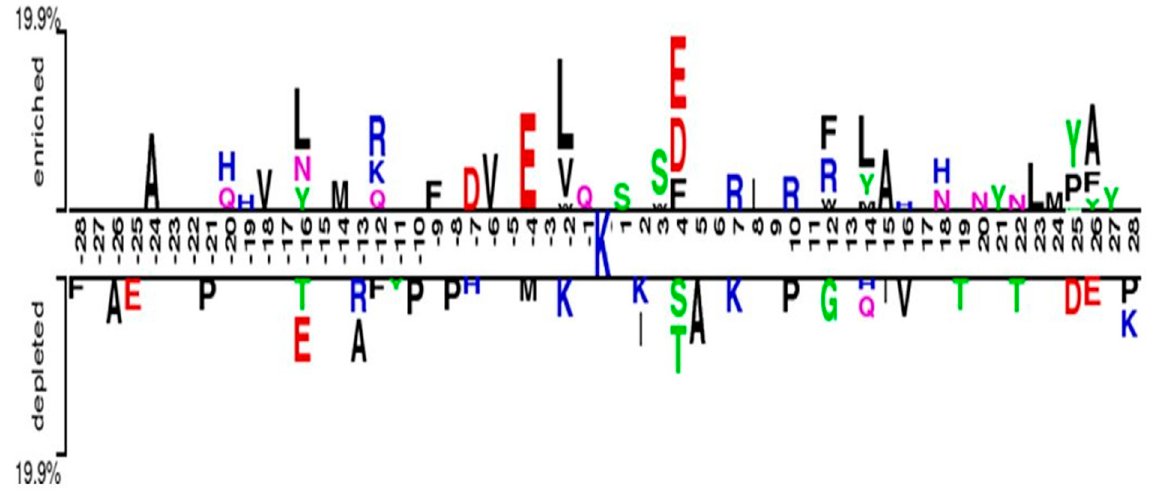
Figure 2. Two sample logo of the pupylation sites.